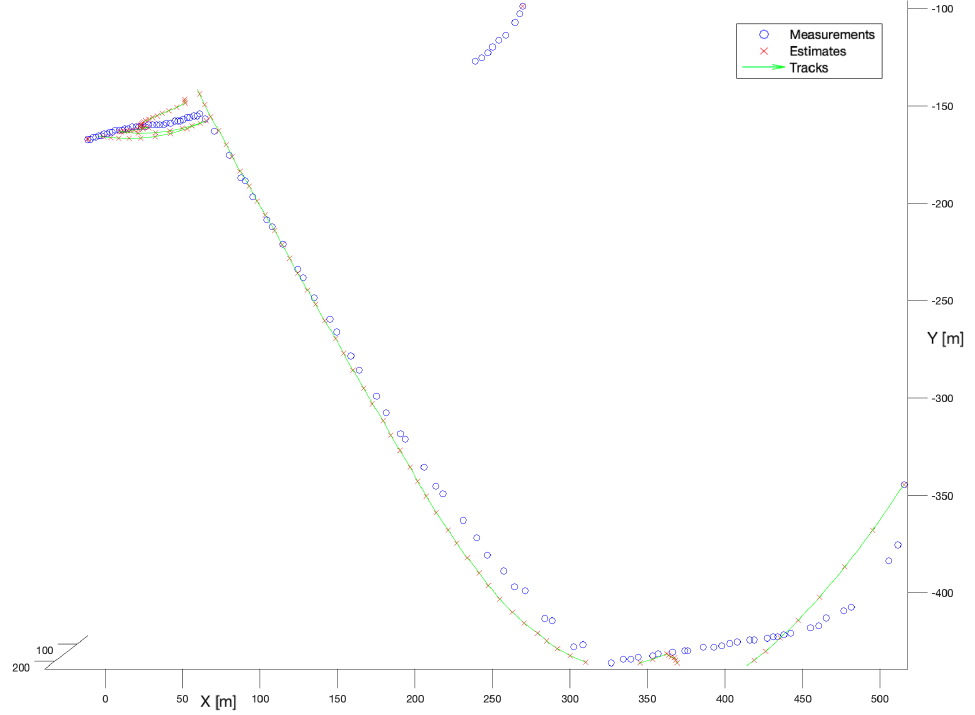
Figure 9. Kalman Filter + Nearest-Neighbour. Multiple bird flight